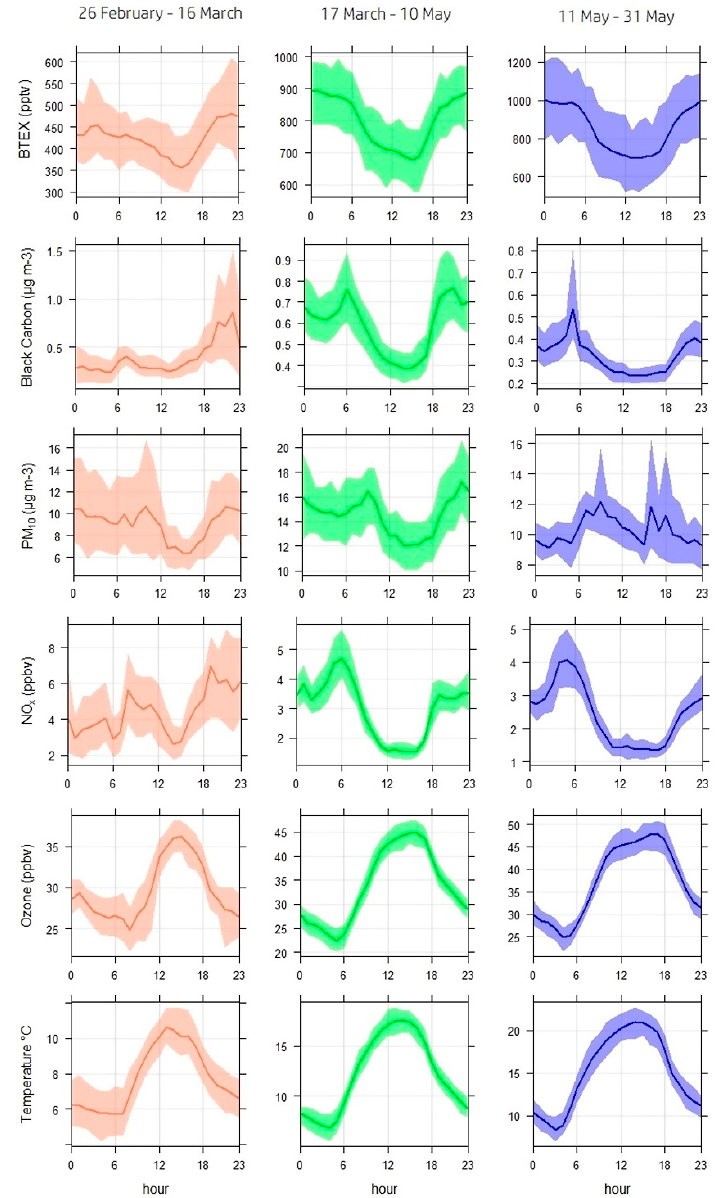
Figure 3. Diurnal variations in BTEX, BC, PM 10 , NO x , O 3 , and temperature before, during and after lockdown. The shaded area represents 95% confidence interval in mean.